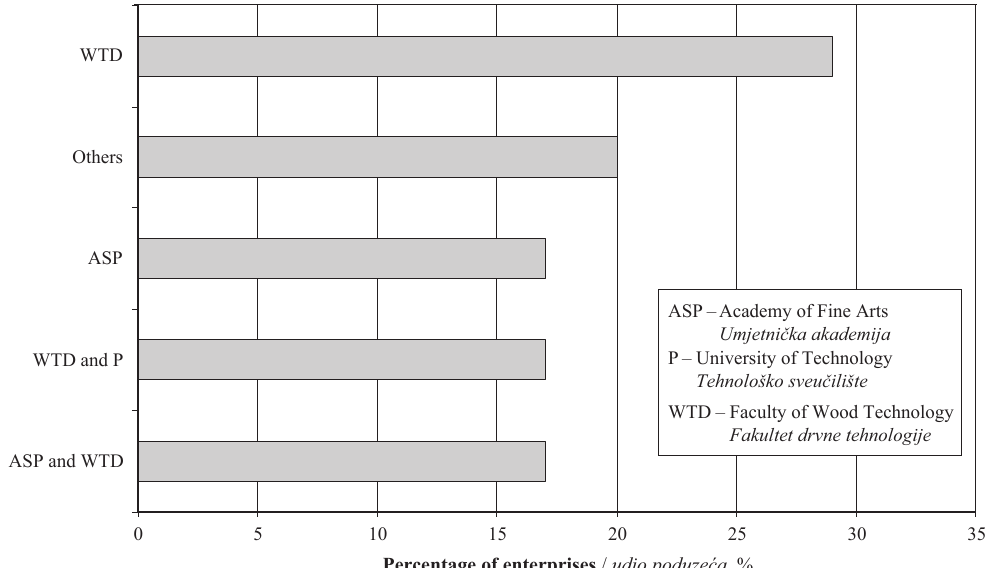
Figure 6 Structure of analysed furniture enterprises depending on the vocational preparation of individuals designing furniture Slika 6 . Struktura analiziranih tvrtki za proizvodnju namještaja ovisno o stru č noj osposobljenosti pojedinaca koji dizajniraju namještaj